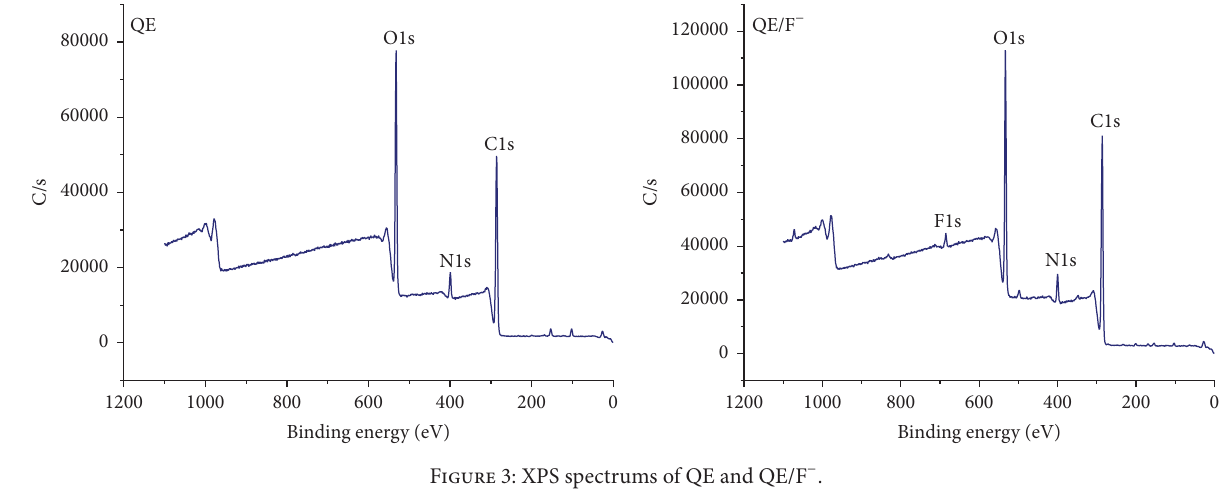
Figure 3: XPS spectrums of QE and QE/F − .